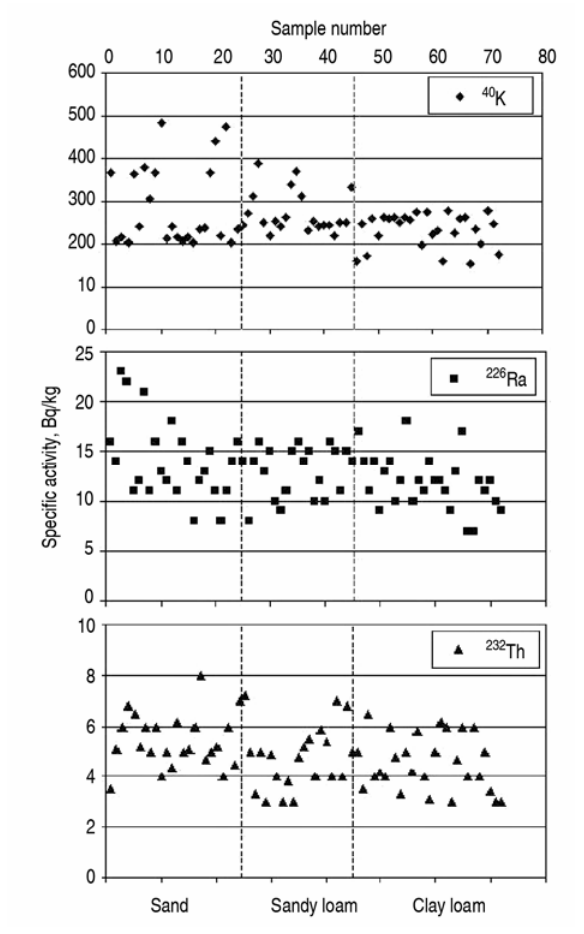
Fig 2 . Specific activity of 232 Th, 226 Ra and 40 K in soil samples of different granulemetric composition